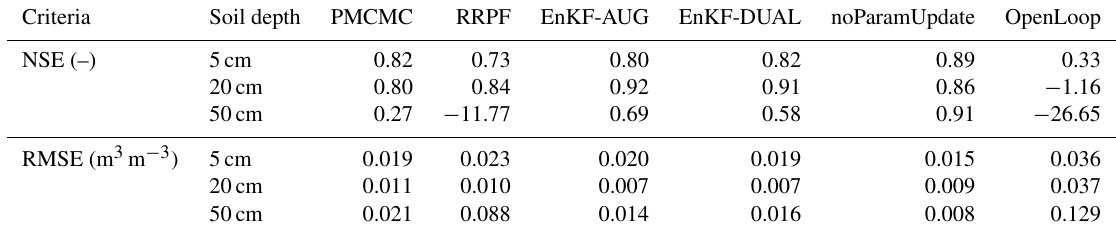
Table 4. Calibration period: values of the NSE and RMSE summary statistics of the quality-of-fit of VIC-3L for the Rollesbroich soil moisture observations at 5, 20, and 50cm depths using the PMCMC, RRPF, EnKF-AUG, and EnKF-DUAL data assimilation methods. For completeness, we also list the performance of the EnKF for state estimation only (noParamUpdate) using VIC-3L parameter values drawn randomly from the prior parameter distribution, and the performance of an open-loop run of VIC-3L (OpenLoop) using the mean simulation of many different VIC-3L parameterizations drawn randomly from the prior parameter distribution (see Table 1 and Sect. 4.2). Criteria Soil depth PMCMC RRPF EnKF-AUG